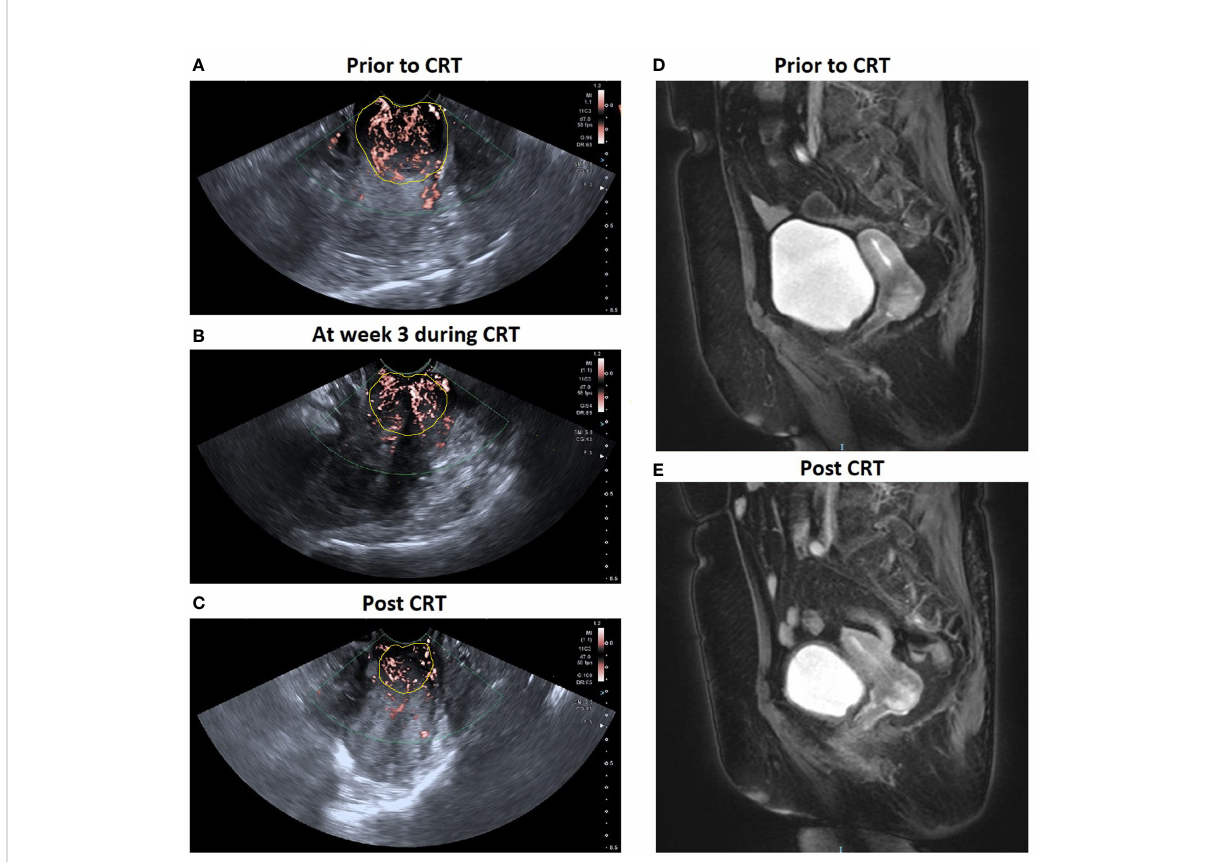
FIGURE 4 A patient with locally advanced cervical cancer (FIGO stage IIB) experienced complete response to CRT. SMI images show a signi fi cant decrease in VI in cervical cancer: (A) 0.398 prior to CRT; (B) 0.323 at week 3 during CRT; (C) 0.278 post CRT. Corresponding axial T2-weighted images exhibited a signi fi cant decrease in the maximal diameter of tumor: (D) 3.5 cm at pre-therapy e and (E) 1.8 cm post therapy.